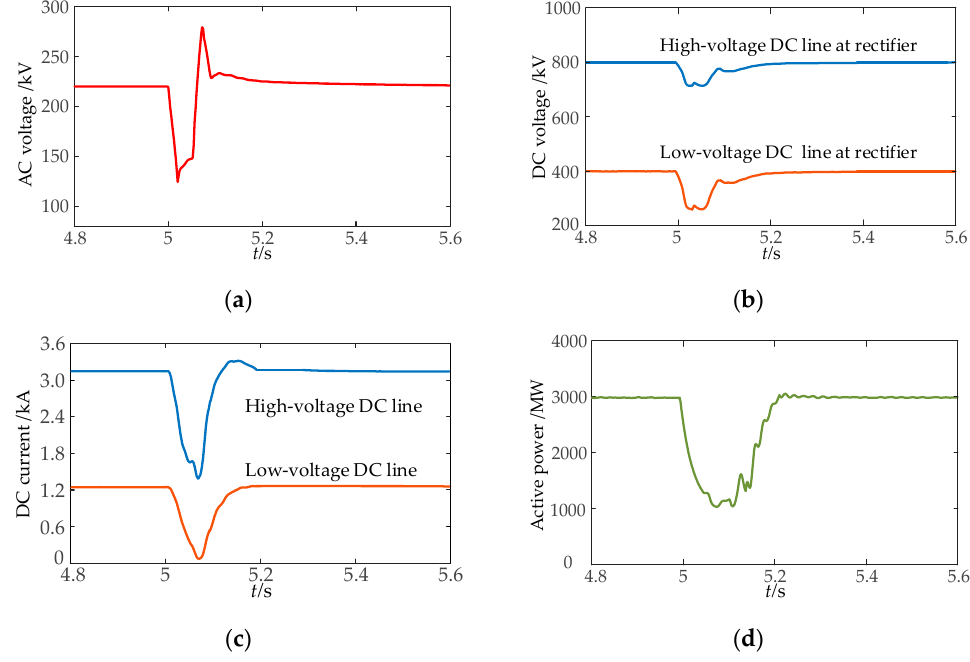
Figure 14. Waveform diagram under fault at inverter side. ( a ) AC voltage at inverter side. ( b ) DC voltage at rectifier side. ( c ) DC current of transmission line. ( d ) Active power of system.